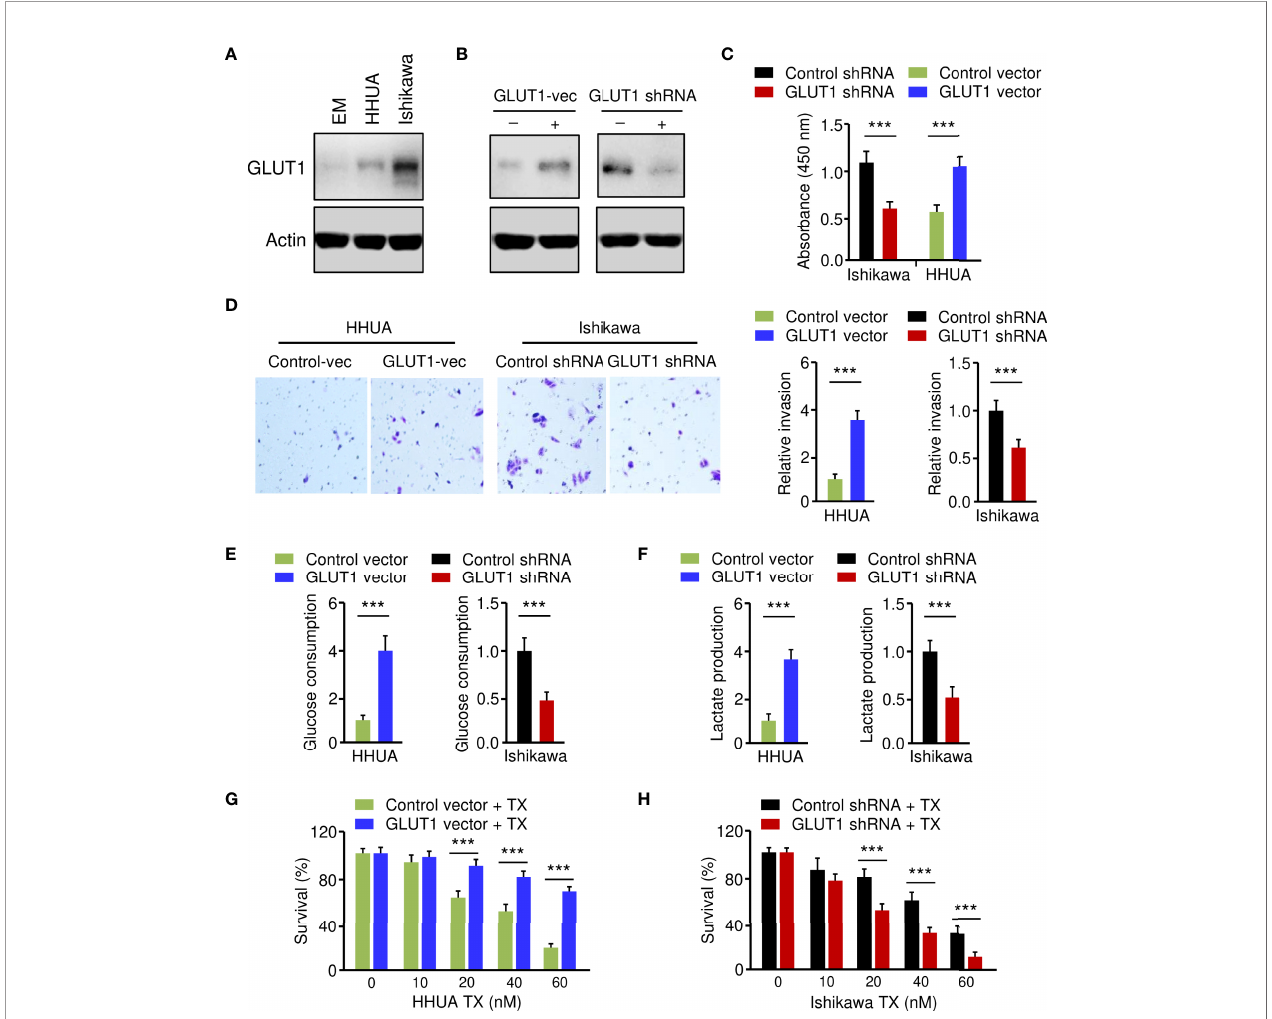
FIGURE 2 | Critical Roles of GLUT1 in Promoting EC Cell Phenotypes. (A) Western blotting analysis of GLUT1 protein expression in a normal endometrial cell line (EM) and human EC cell lines. (B) Western blotting analysis of GLUT1 expression in GLUT1-overexpressing HHUA cells and Ishikawa cells with GLUT1 silencing. (C – F) EC cell proliferation (C) , invasion (D) , glucose consumption (E) , and lactate production (F) assays following GLUT1 overexpression or knockdown. (G, H) GLUT1-overexpressing HHUA cells (G) and Ishikawa cells after knockdown of GLUT1 (H) were treated with different concentrations of paclitaxel, and cell